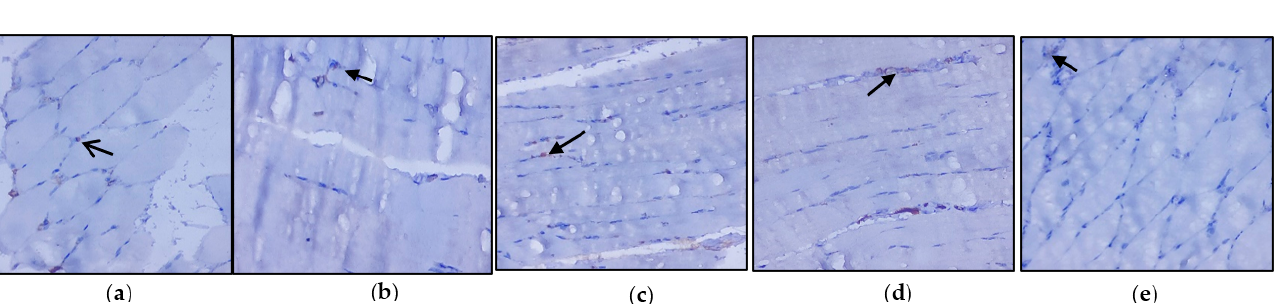
Figure 3. ( a ) IRS-1 mRNA expression levels in ethanolic extract of C. papaya in control and diabetic rats; ( b ) Akt mRNA expression levels in ethanolic extract of C. papaya in control and diabetic rats.